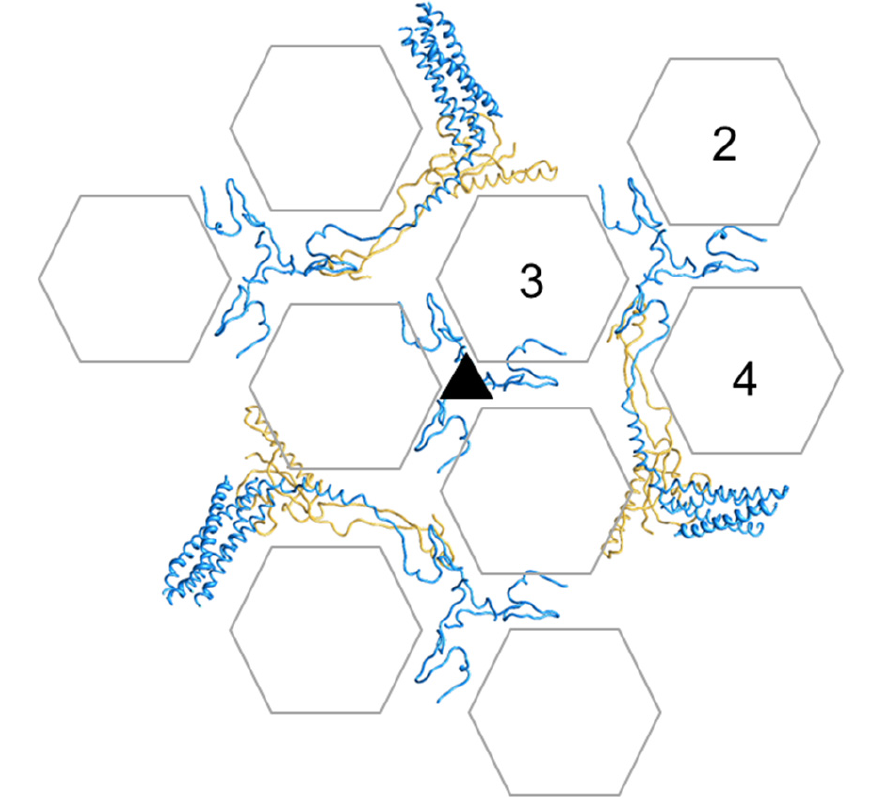
Figure 5. Cementing of the GON. Organization of minor coat proteins VIII and IX in the GON. The four copies of IX in one GON are shown in blue, and the three copies of VIII in yellow. Only the fragments of IX that could be traced in the atomic resolution cryoEM map are depicted. Hexon positions are represented as transparent hexagons to allow simultaneous view of IX and VIII. Hexons in one AU are labeled 2 to 4 (hexon 1 is not a part of the GON). The view is from outside the